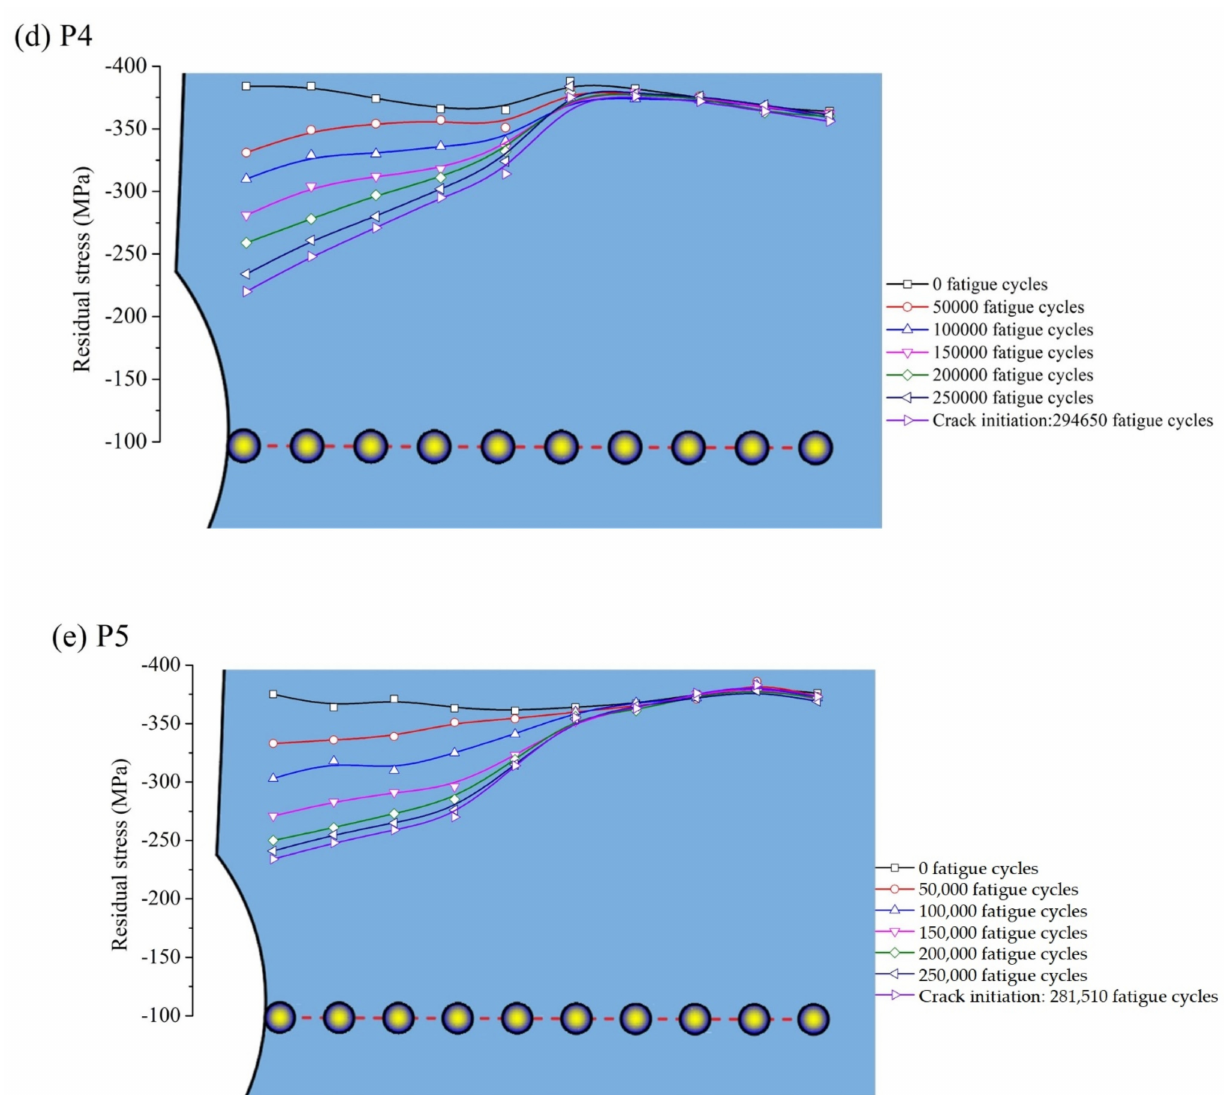
Figure 17. The variety of residual stresses with fatigue loading at each measuring point of ( a ) P1, ( b ) P2, ( c ) P3, ( d ) P4 and ( e )